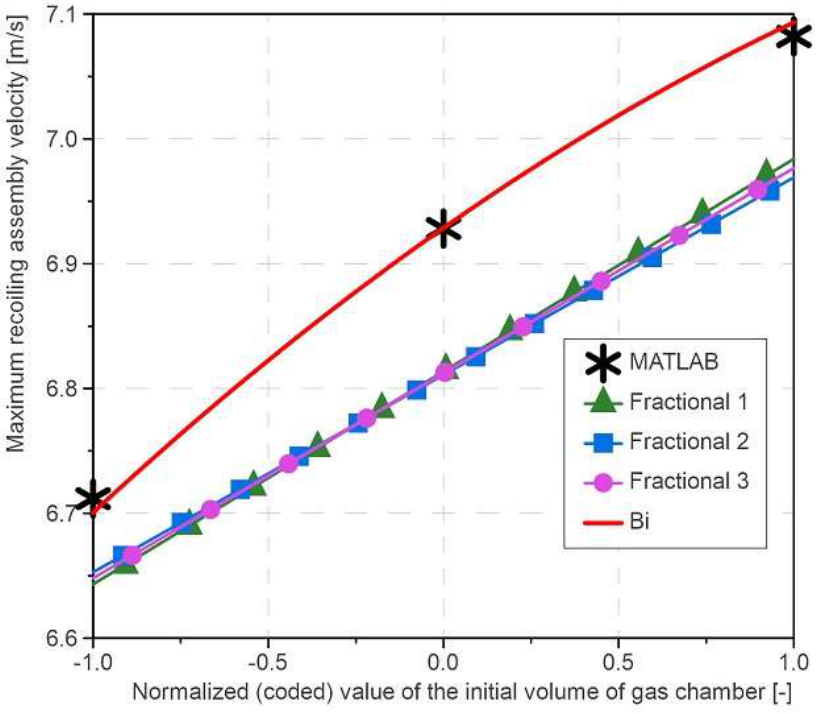
Figure 5. Diagram of the maximum recoiling assembly velocity as a function of the normalized (coded) value of the initial volume of the gas chamber.